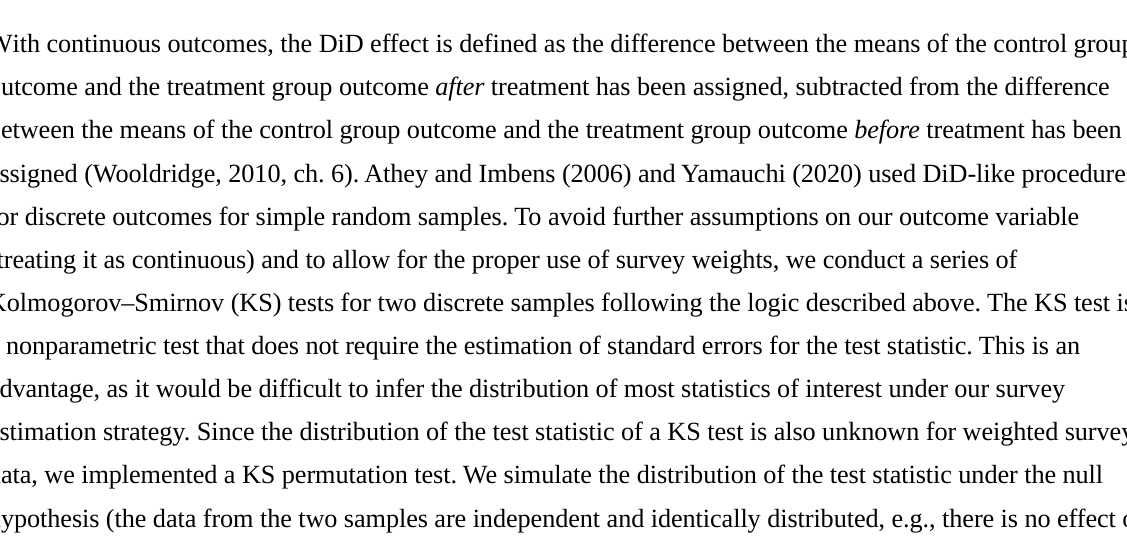
Figure 2. Difference-in-differences (DiD) identification strategy. Schematic representation of a mean